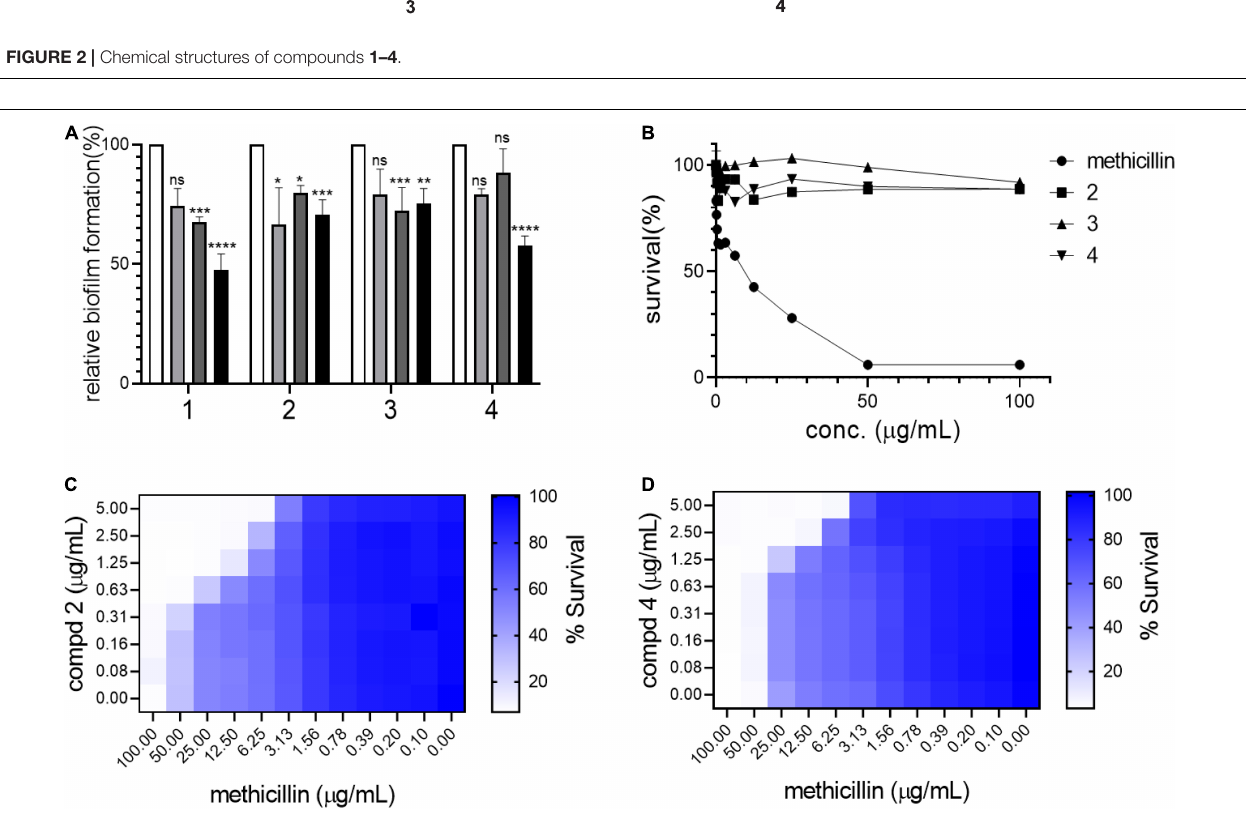
FIGURE 3 | Compounds kill USA300 by resensitizing bacterial cells to methicillin. (A) Biofilm formation assays were performed at 0 (white bar), 5 (light gray), 20 (dark gray), and 50 (black) µ g/mL of compounds 1–4 . Statistically significant differences were defined as * P ≤ 0.05; ** P ≤ 0.01; *** P ≤ 0.001; and **** P ≤ 0.0001. (B) Survival of USA300 were measured under compound treatments. Compounds and methicillin combination treatment shows synergistic activity against USA300 (C,D) . Heatmap plots were generated from checkerboard assay for combination treatment of methicillin and compounds 2 and 4 .